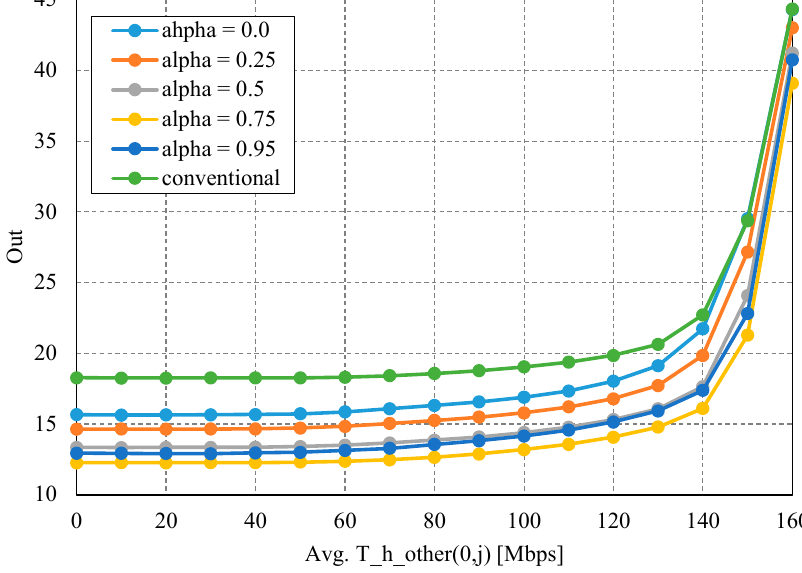
(0,𝚥)(cid:3364)(cid:3364)(cid:3364)(cid:3364)(cid:3364)(cid:3364)(cid:3364)(cid:3364)(cid:3364)(cid:3364)(cid:3364)(cid:3364)(cid:3364)(cid:3364) with parameter of 𝛼 . ( 0, j ) with parameter of α (cid:3173)(cid:3178)(cid:3166)(cid:3163)(cid:3176) other